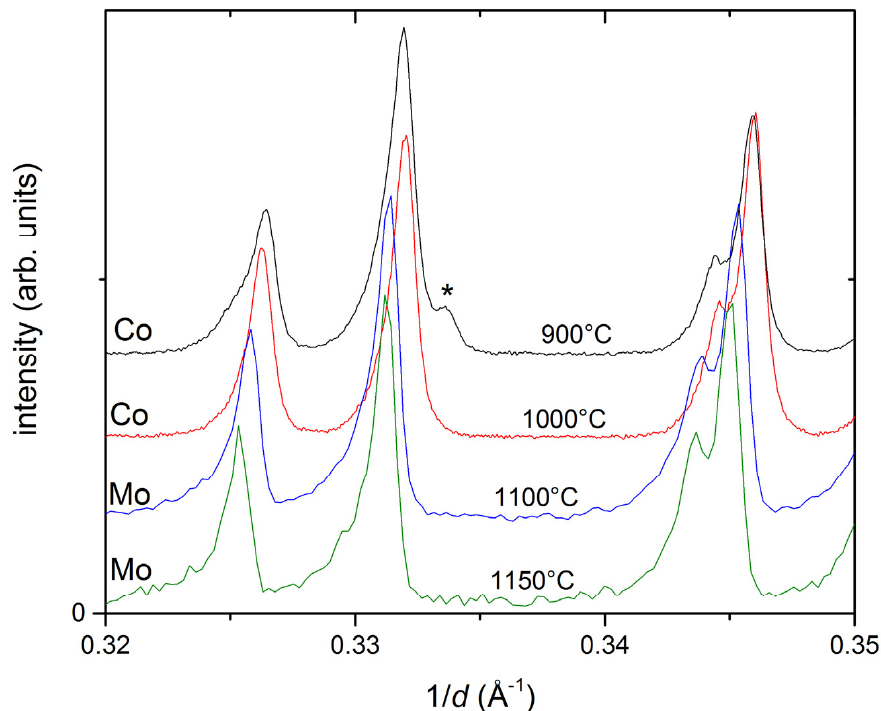
Figure 1. Powder X-ray diffraction data of Ca 1 − x Ir 4 S 6 (S 2 ) as obtained from samples reacted at different temperatures. Co and Mo indicate which samples were measured with Co-K α or Mo-K α radiation, respectively. The impurity peak from the reaction at 900 °C is marked with *.